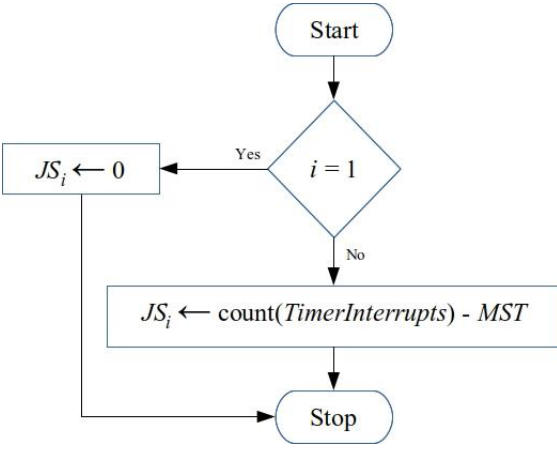
Figure 1. Supply appropriate values for the JS field.